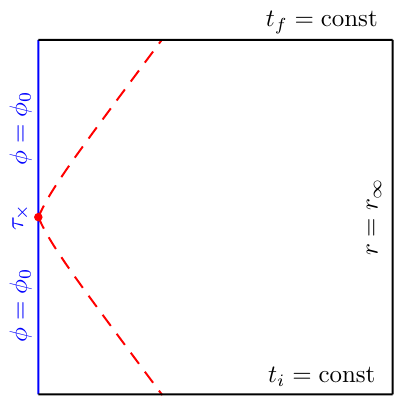
Figure 6 . Schematic representation of the regularized scattering solution. Red dashed line shows the particle